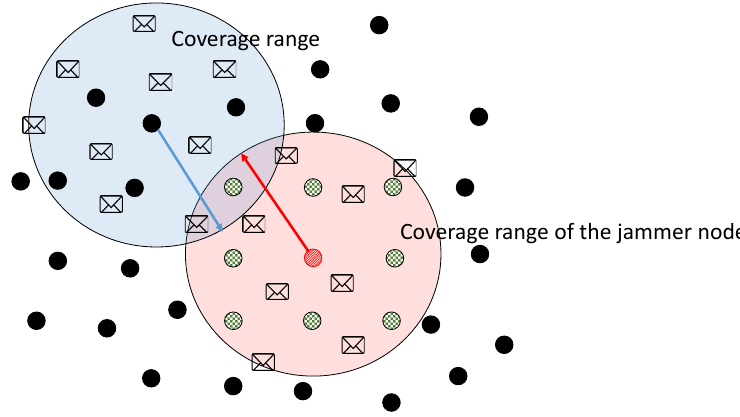
Figure 2. Coverage range of the jammer node and its influence in its